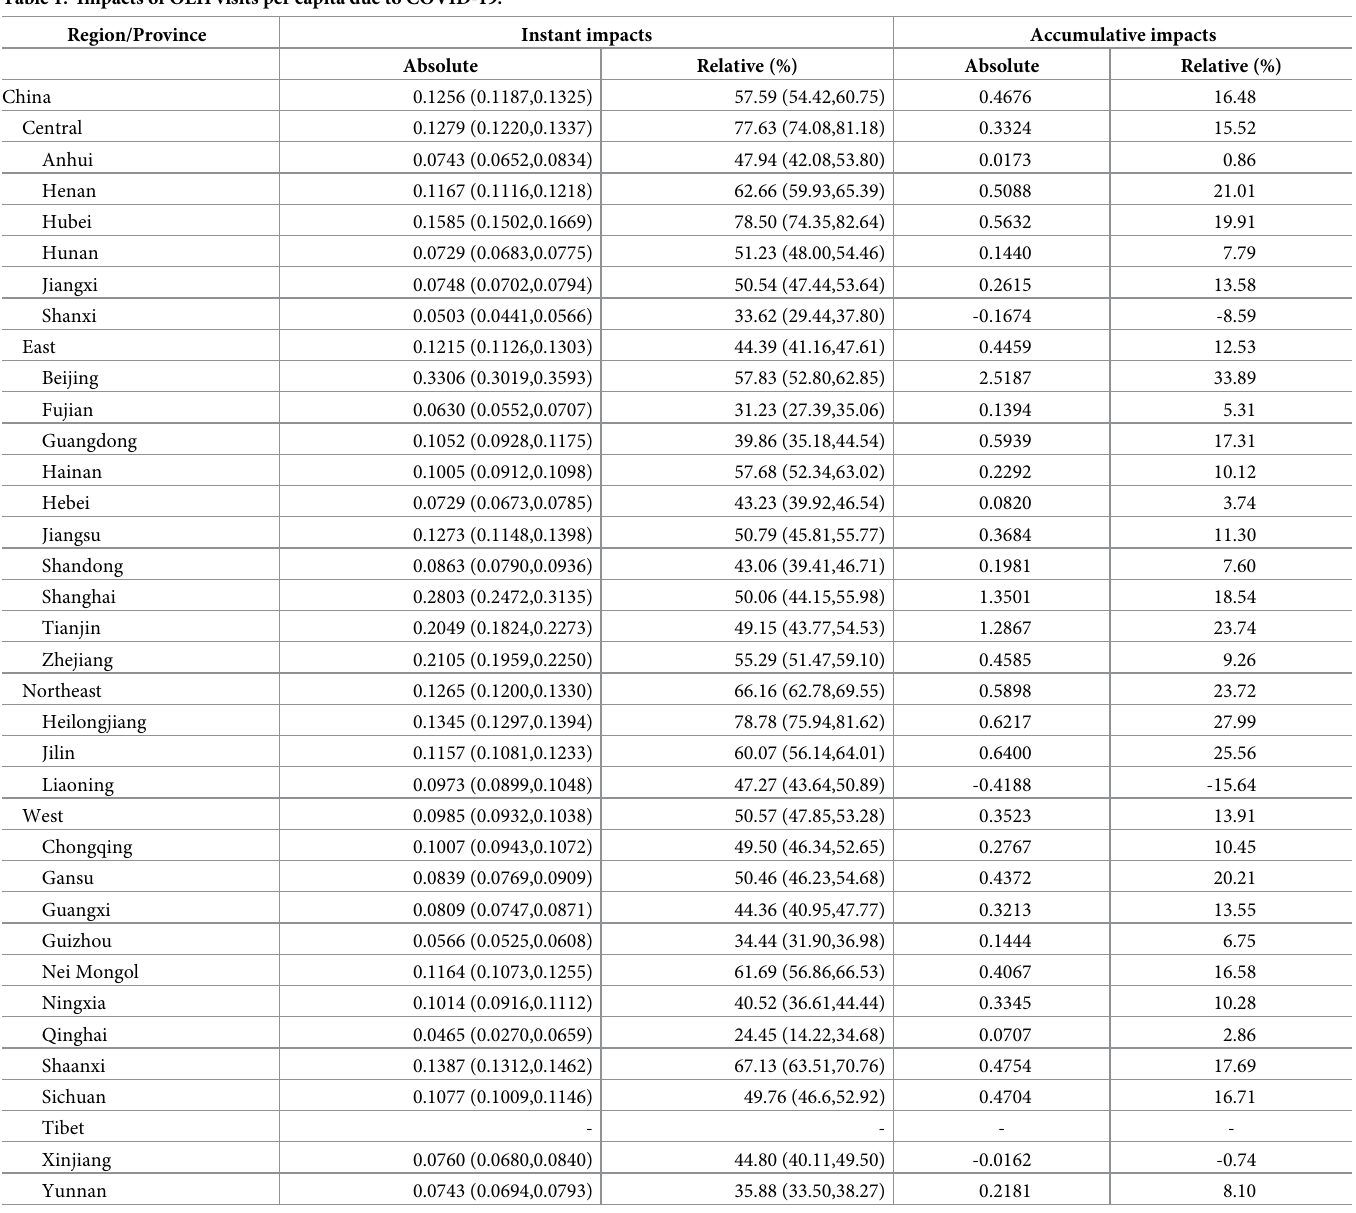
Table 1. Impacts of OEH visits per capita due to